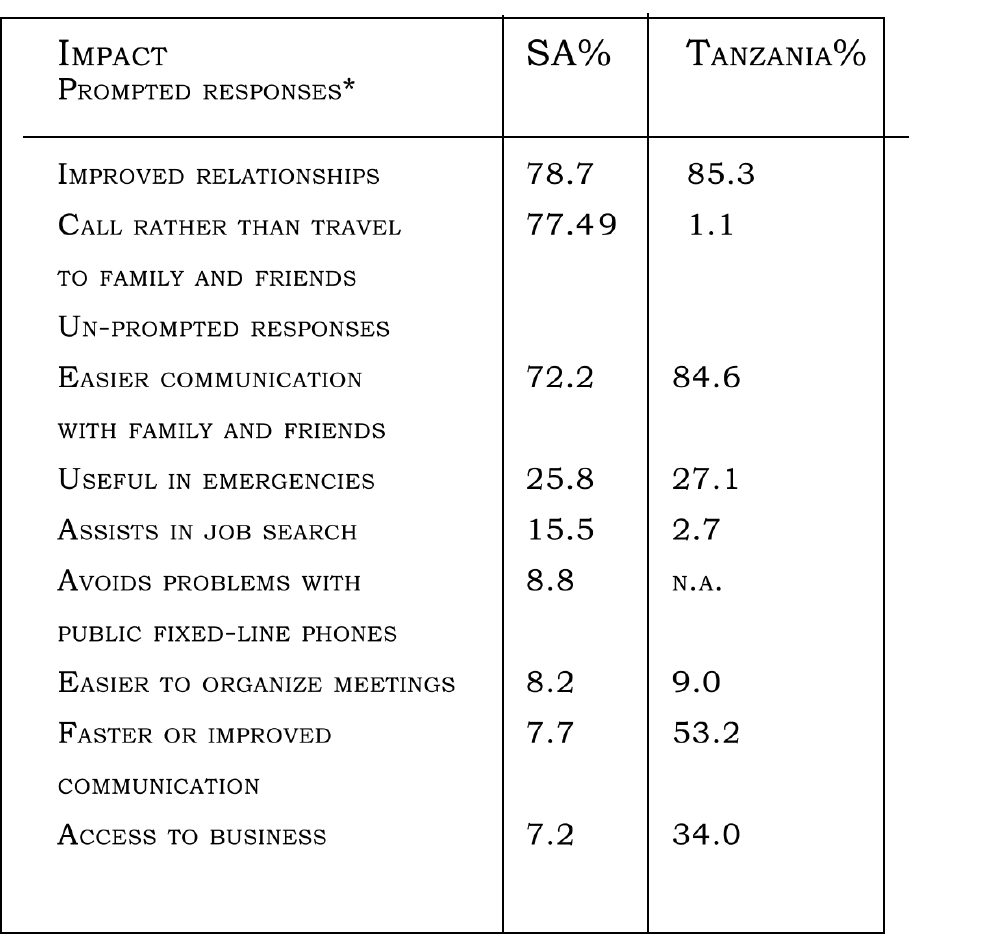
Table 2. Impact of mobile phones of